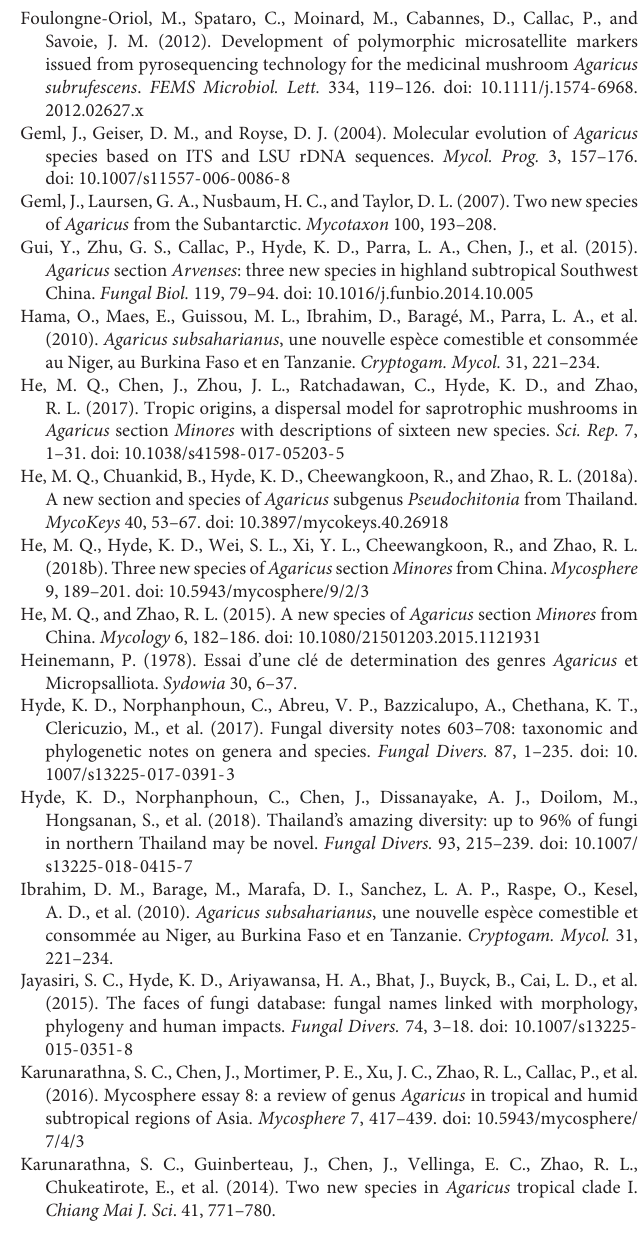
Supplementary Table 1 | Names, voucher numbers, countries and the corresponding GenBank accession numbers of the taxa used in the phylogenetic analyses. The sequences obtained in this study are in bold and superscript “T” refers to a